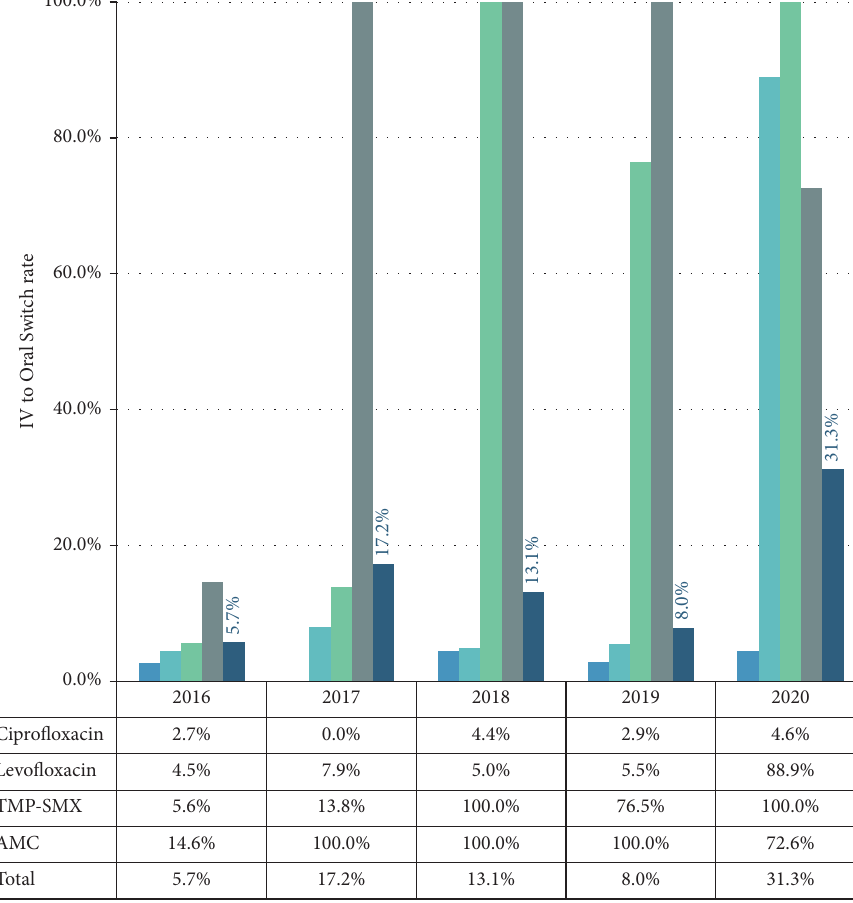
Figure 1: IV-to-oral switch rates of index antibiotics following the implementation of the antimicrobial stewardship program